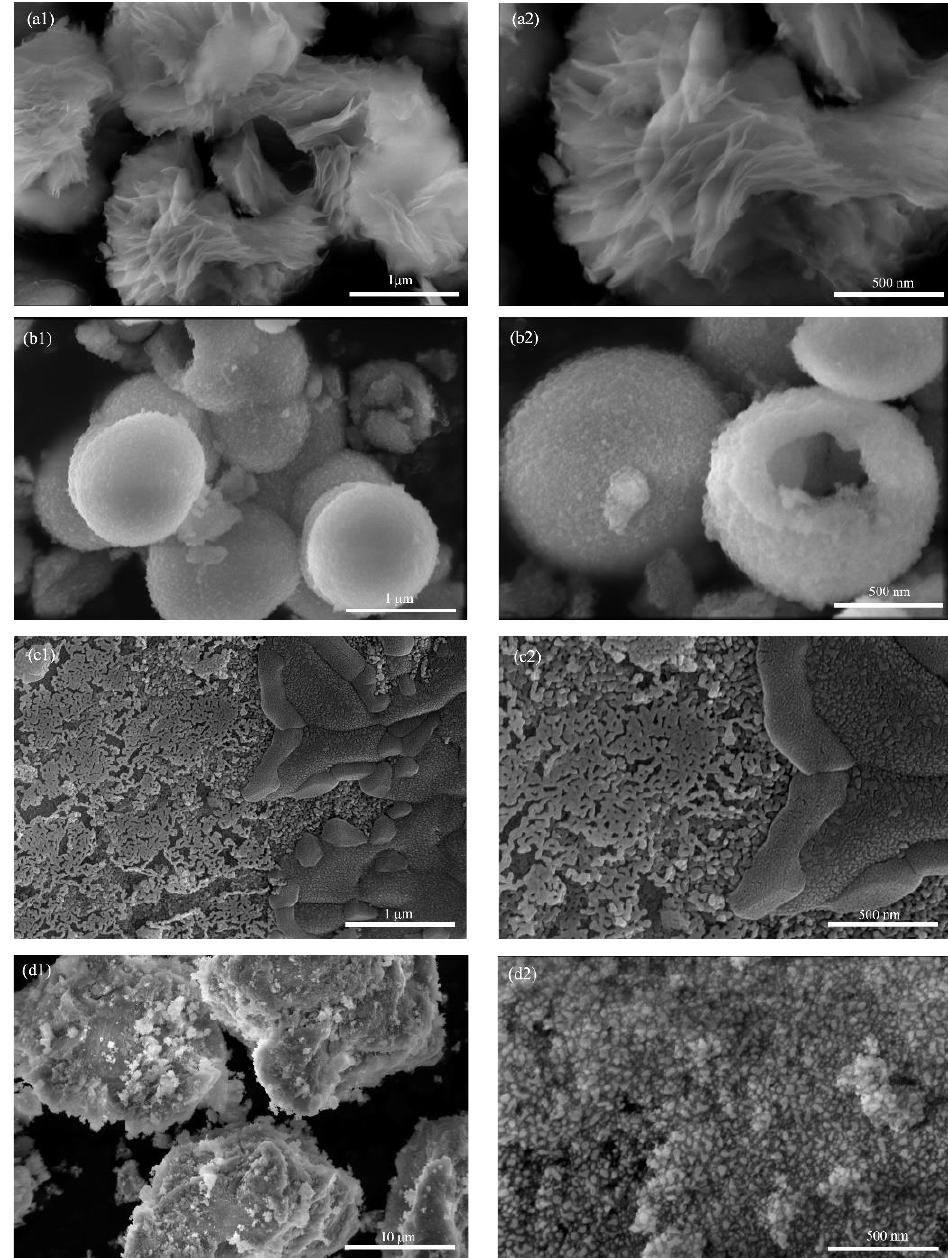
Figure 1. SEM images of fresh FlYZr ( a1 , a2 ), SpYZr ( b1 , b2 ), ReYZr ( c1 , c2 ), BuYZr ( d1 , d2 ).